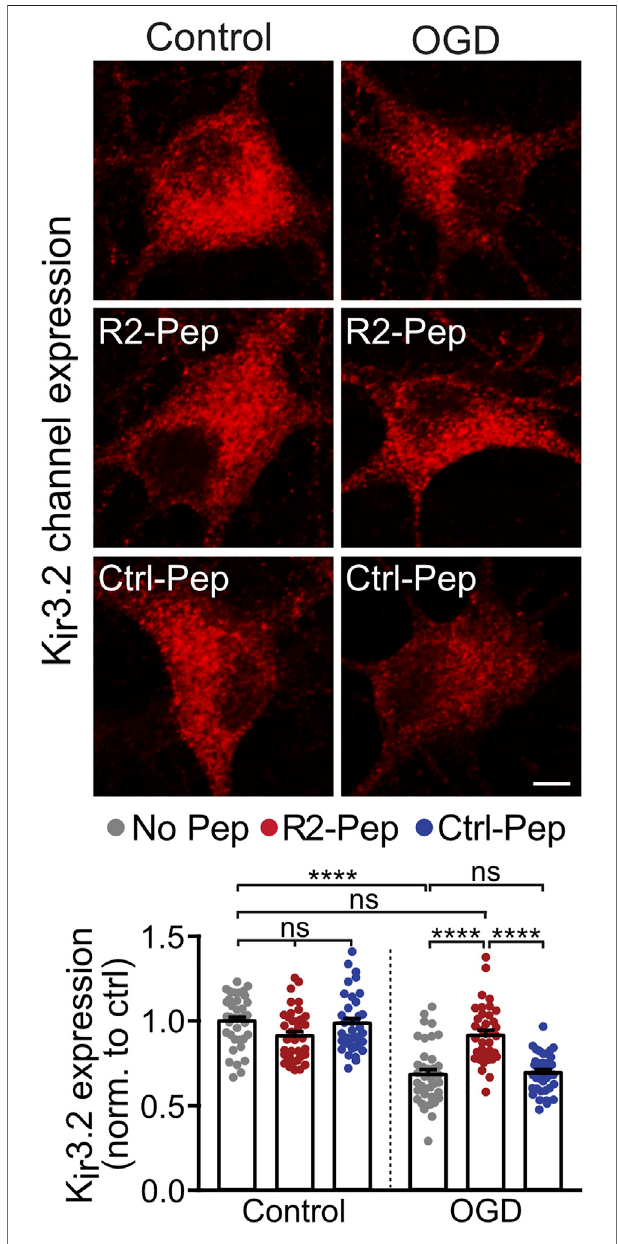
FIGURE 5 | R2-Pep normalize OGD-mediated dysregulation of K ir 3.2 channels. Cultures were stressed for 1 h with OGD and immediately treated with R2-Pep, Ctrl-Pep or remained untreated. After 16 h neurons were immunostained for K ir 3.2 channel expression. Top: representative images (scale bar: 5 μ m). Bottom: quanti fi cation of fl uorescence intensities. The fl uorescence intensity of the untreated neurons served as control. The data represent the mean ± S.E.M. of 37 – 38 neurons from two independent preparations. ns: p > 0.05; ****, p < 0.0001; two-way ANOVA with Tukey ’ s multiple comparisons